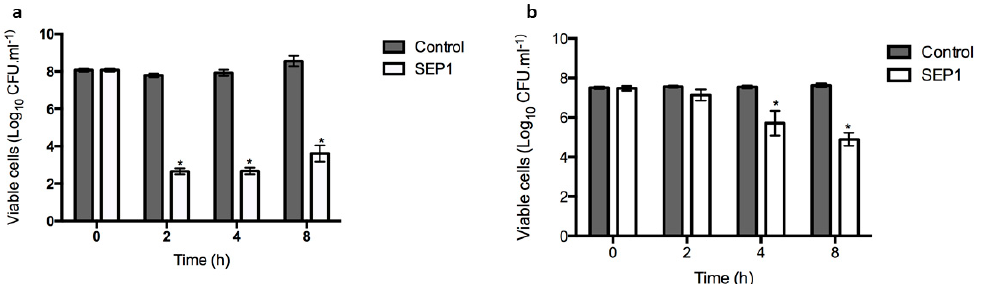
Figure 2. SEP1 phage infection of planktonic S. epidermidis 9142 planktonic cultures. ( a ) biofilm-released cells and ( b ) persister cells were infected with SEP1 using a MOI of 1. Data was assessed by CFU counting and the values represent the mean plus and minus of three independent experiments performed in triplicate. Statistical di ff erences ( p < 0.001) between control and SEP1-treated cells (*) were determined by two-way repeated-measures analysis of variance (ANOVA) with Bonferroni post hoc